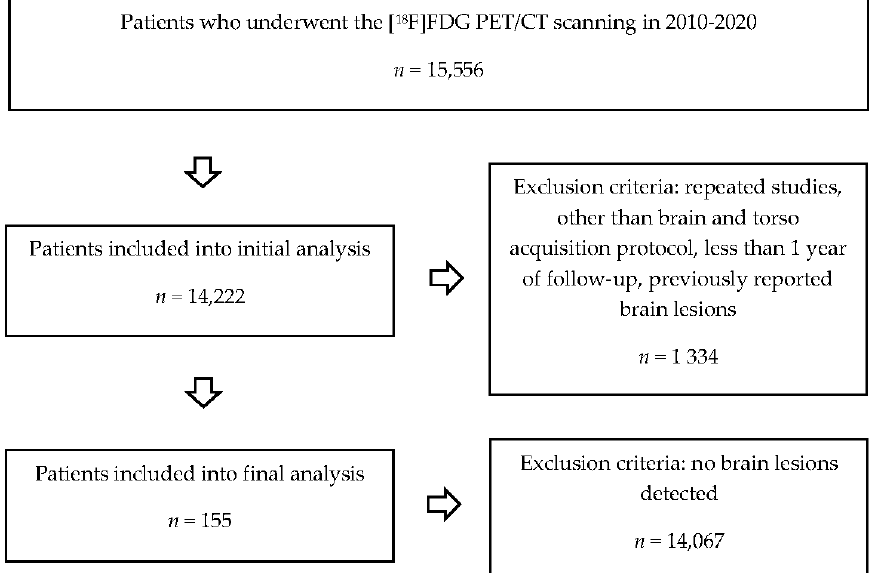
Figure 2. Flow diagram of database collection (source: original figure).